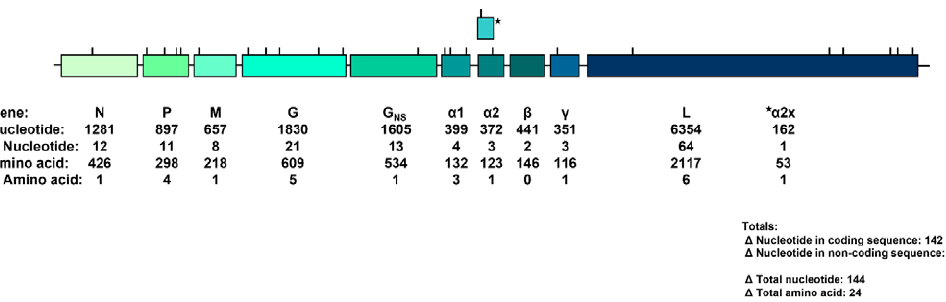
Figure 2. Yata virus genome with nucleotide and amino acid difference between the YATAV isolate UG12209 and the original isolate, DakArB 2181. Tick marks represent the relative locations of amino acid differences in each open reading frame.